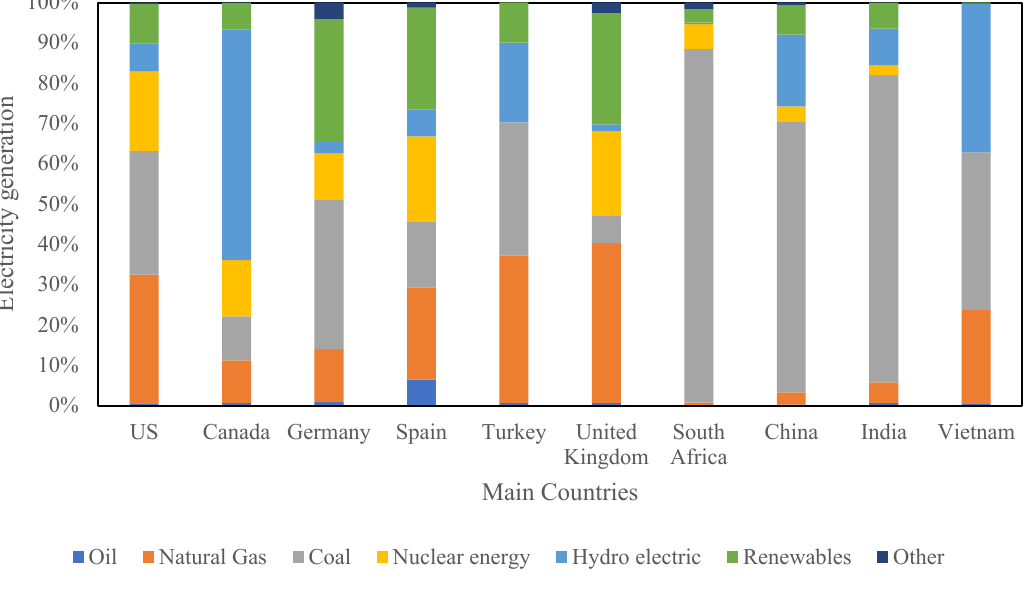
Figure 4. Electric power generation structure in major countries.